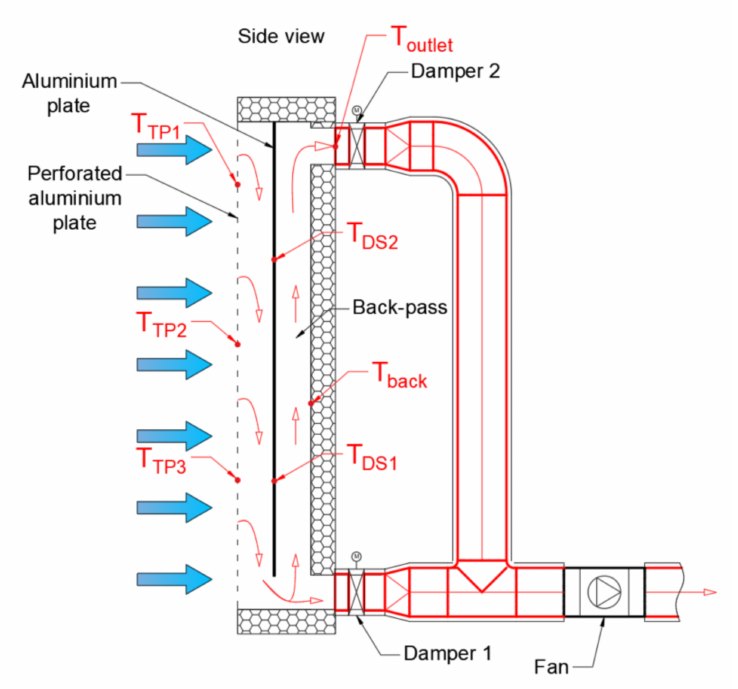
Figure 1. Building-integrated solar air